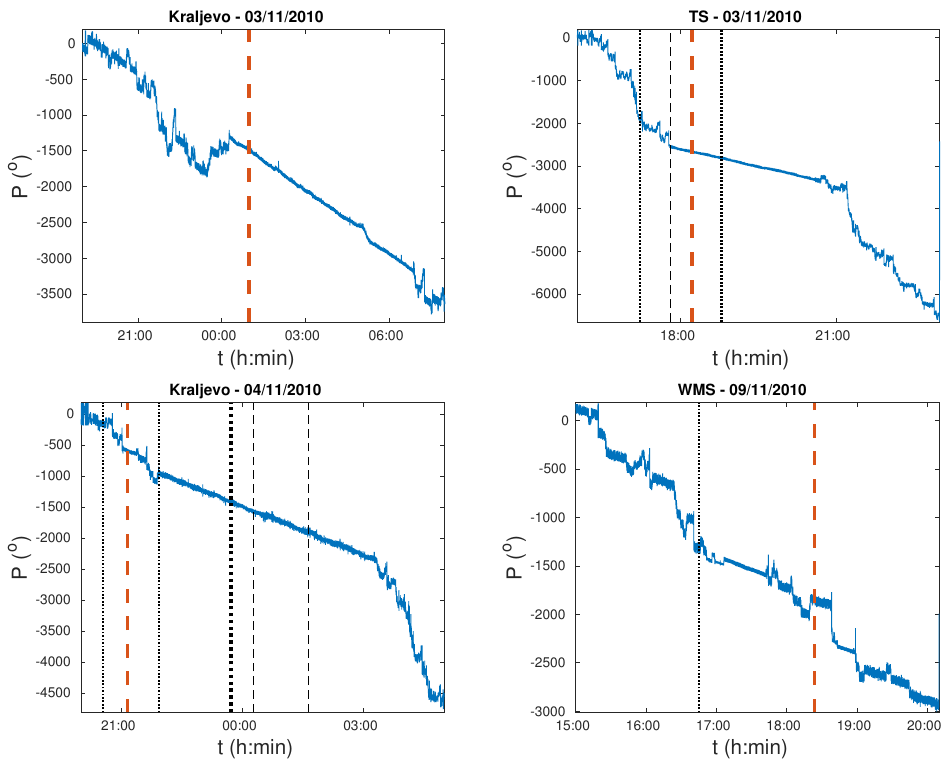
Figure 2. Time evolutions of the unwrapped phase P for the considered periods. Red lines represent the main EQ considered in corresponding time periods. The additional events listed in Table 1 are coloured in black. Times of the additional considered EQ events with magnitude below 2.5, from 2.5 to 3, and from 3 to 4 are represented by thin dotted, thin dashed and tick dotted black lines,